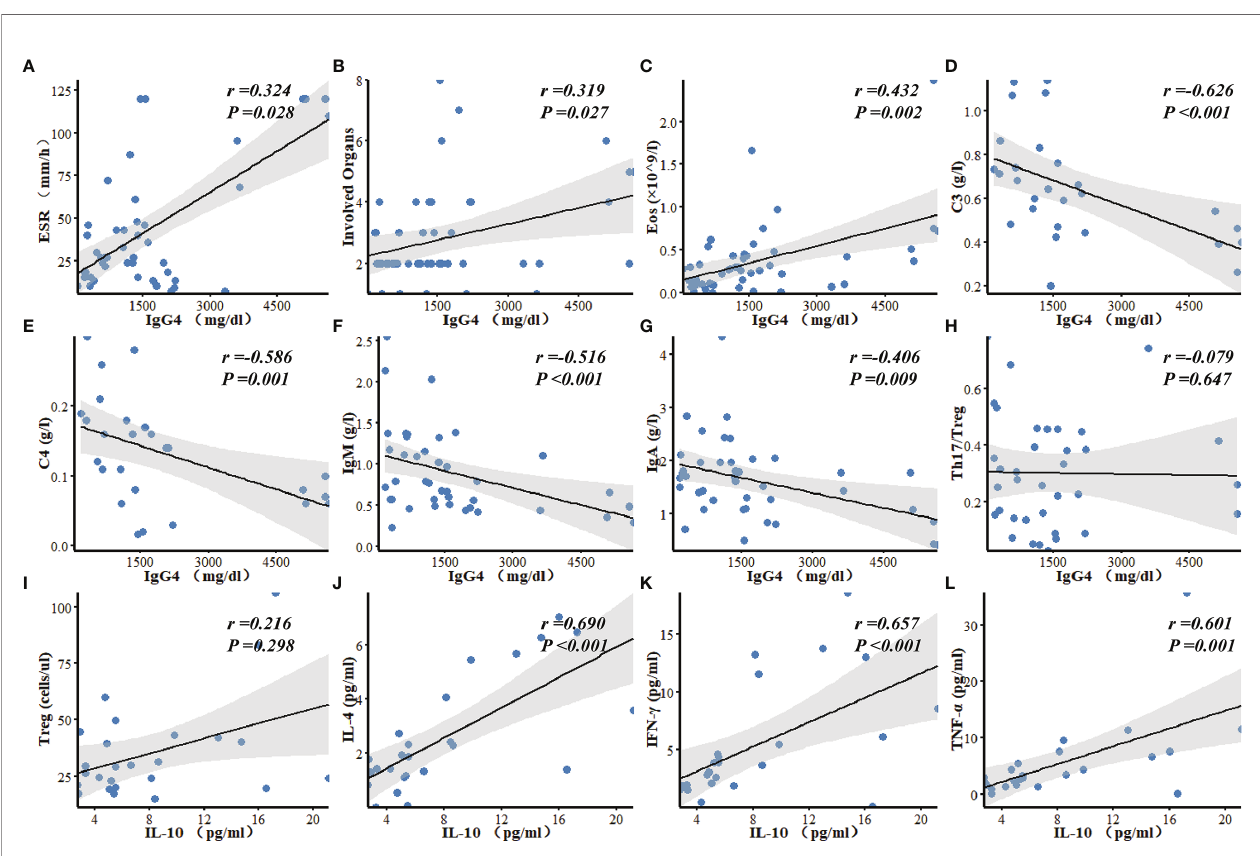
FIGURE 2 | Correlation analyses of laboratory fi ndings in patients with IgG4-RD. (A – G) Serum IgG4 level was positively correlated with ESR, the number of involved organs, and Eos, and negatively correlated with C3, C4, IgM, and IgA. (H) There was no correlation between serum IgG4 level and Th17/Treg ratio in IgG4-RD patients. (I – L) Serum IL-10 was uncorrelated with Treg, but positively correlated with IL-4, IFN- g and TNF- a . Eos, eosinophils; C3, Complement 3; C4, Complement 4; Ig, Immunoglobulin.